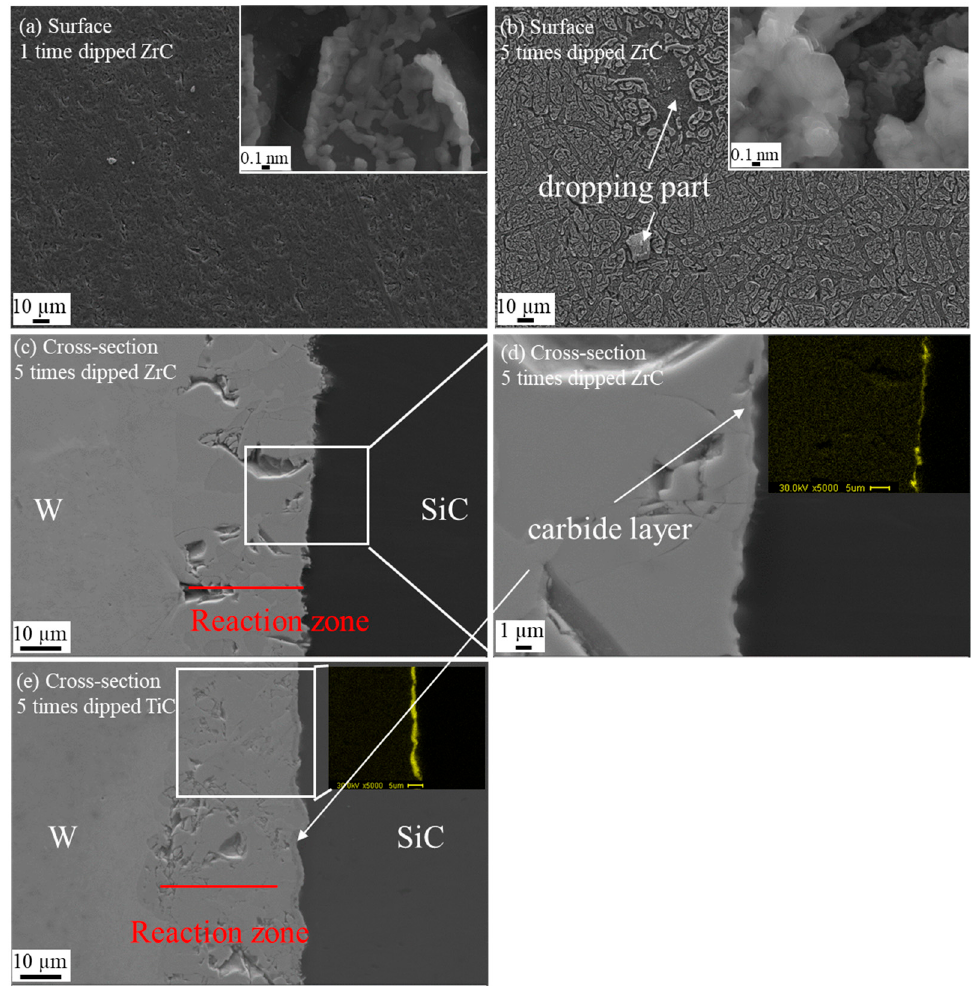
Figure 8. The surface and cross-sectional SEM images of dipped carbides film coated SiC before and after joining. ( a ) the surface of 1-time dipped ZrC coated SiC before joining, ( b ) the surface of 5-times dipped ZrC-coated SiC before joining, ( c ) 5-times dipped ZrC coated SiC joined with W; ( d ) 5-times dipped ZrC-coated SiC joined with W with larger magnification; ( e ) 5-times dipped TiC-coated SiC joined with W.